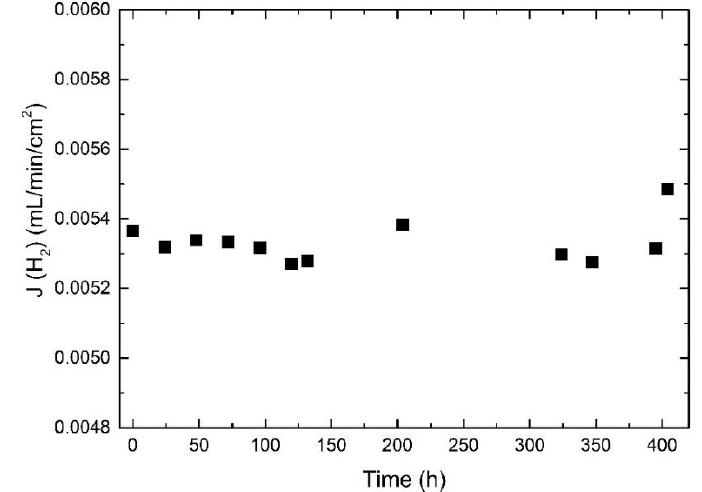
Figure 13. Apparent hydrogen flux as a function of time using WF + WS at 750 °C. The feed side is wet 48.75% H 2 , and the sweep Ar flow is 25 mL/min.